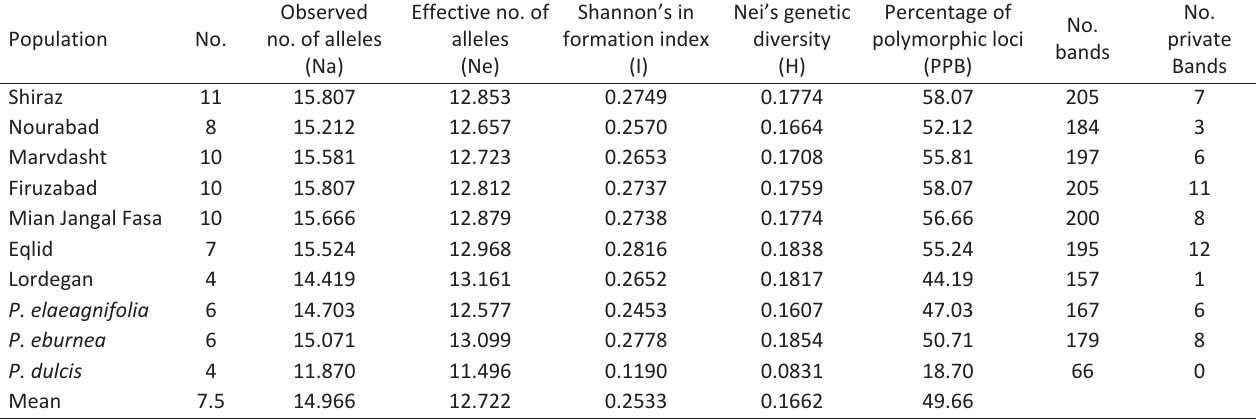
Table 3 ­ Genetic diversity within the populations of almond in Iran exhibited by inter simple sequence repeat (ISSR) Population No.